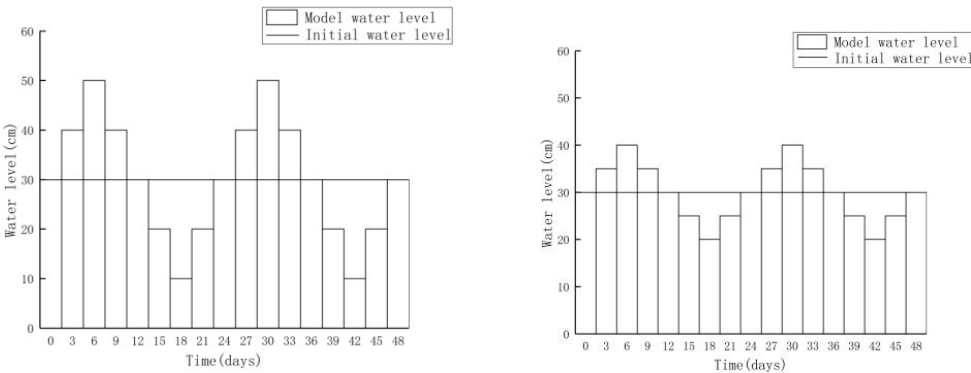
Figure 11. Comparison of Water Level Changes.